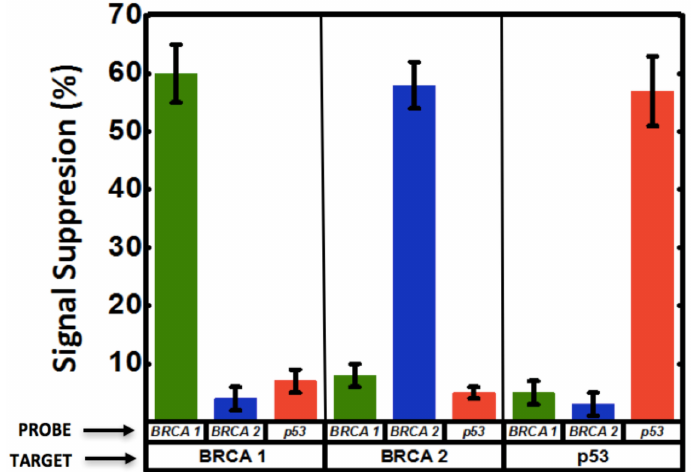
Figure 5. Multiplexed detection of breast cancer-related biomarkers. Three different DNA capture probes (BRCA1, BRCA2 and p53) were grafted on three adjacent electrodes encapsulated in a microfluidic channel. SWV of the interaction of grafted probe DNA with redox marker methylene blue (MB) is measured, as well as the SWV response of each of the electrodes to the different target sequences introduced (BRCA1, BRCA2 and p53) to each microfluidic device. Significant signal suppression was observed when the sample contained the target sequence corresponding to the electrode being interrogated via SWV, while the other two electrodes showed minimal change in signal. The signal suppression observed for all electrodes in response to the targets is summarized as a bar